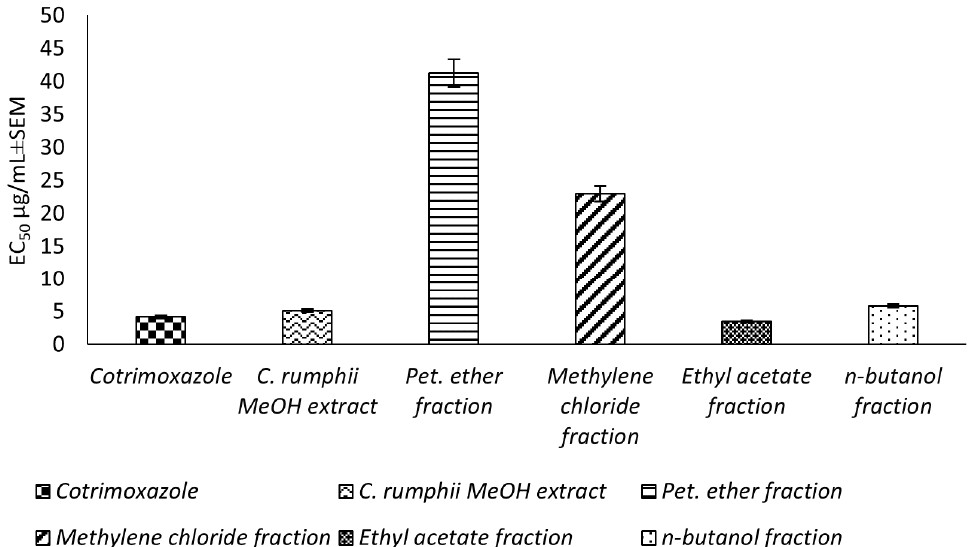
Figure 1. Toxoplasmocidal effect (EC 50 ± SEM) of C. rumphii methanol extract and its different frac- fractions against T. gondii tions against T. gondii .